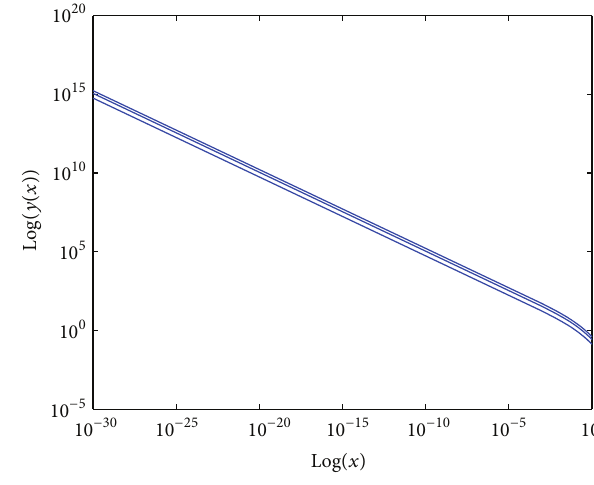
Figure 1: Solution of Example 4, Case I, 𝛽 = 1 .